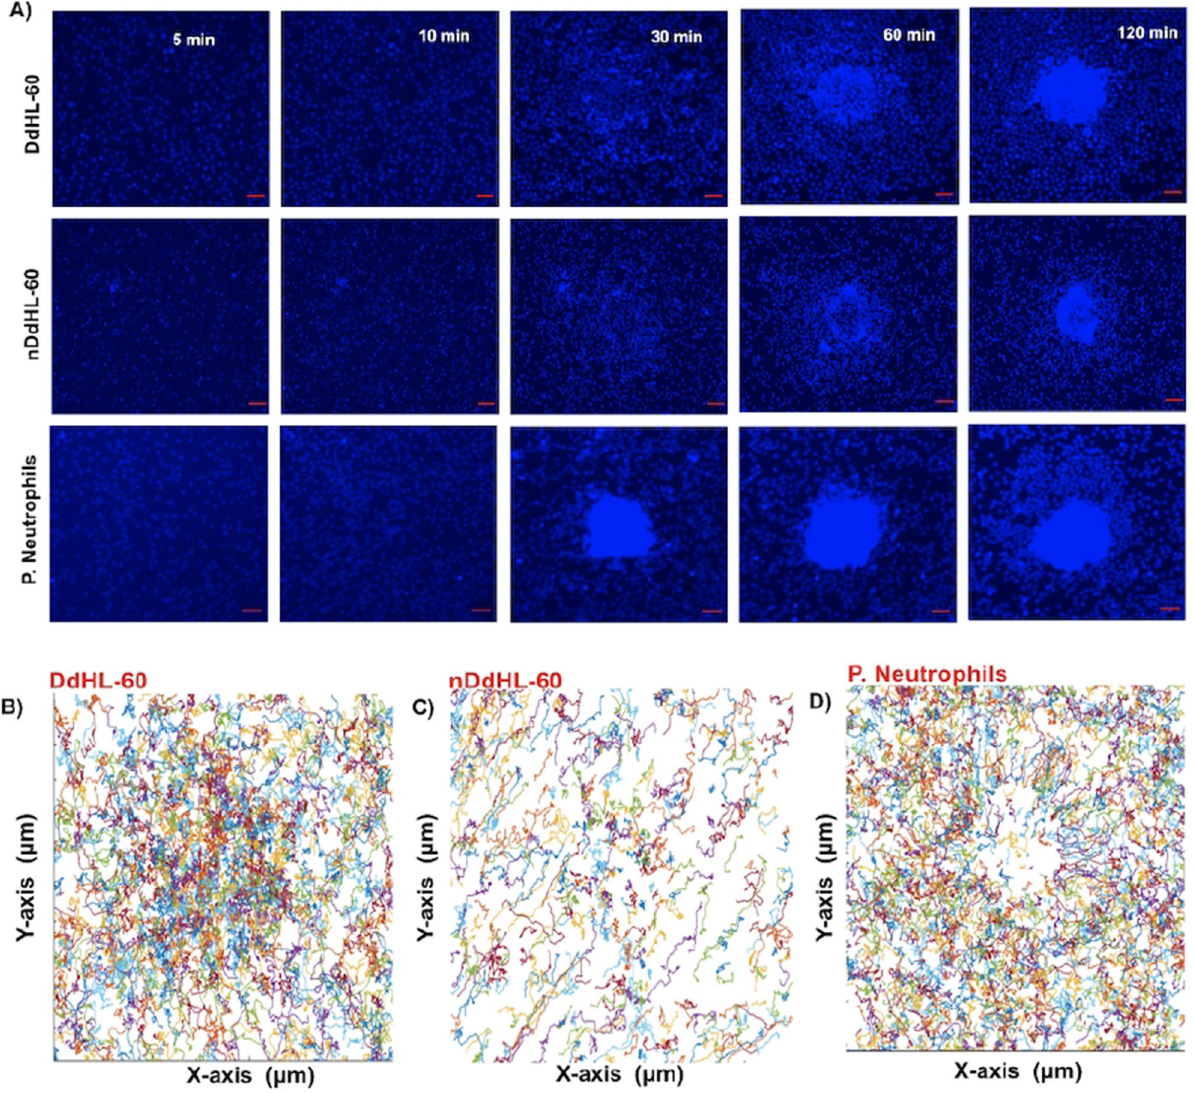
Figure 5. Swarming and aggregation of DdHL-60, nDdHL-60, and primary neutrophils on zymosan-cluster targets. ( a ) Sequential images showing swarm formation in DdHL-60, nDdHL-60 and primary neutrophils (blue) around patterned zymosan particle clusters at 5 min, 10 min, 30 min, 60 min and 120 min (scale bar: 25 µm). Moving ( b ) DdHL-60, ( c ) nDdHL-60, ( d ) primary neutrophils display random and precise track trajectories respectively toward centered zymosan particle. Figure shows representative experiments of N =